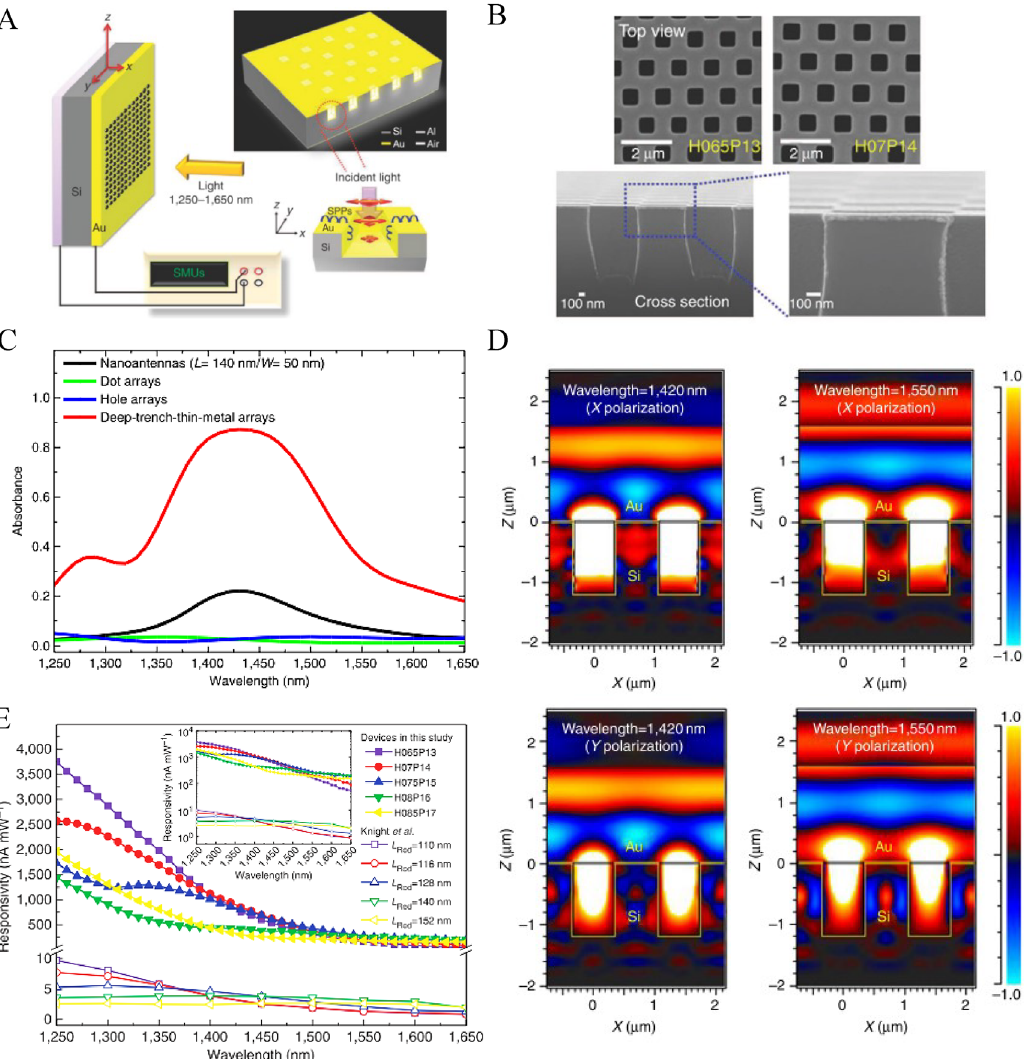
Figure 8: (A) Schematic representation and (B) top-view and cross-section SEM images of the active optical antenna-based device featuring DTTM antenna. (C) Simulated absorbance spectra of different plasmonic nanostructures, including DTTM antenna, nanorods, dot arrays, and hole arrays. (D) The electric field distributions of the light at the wavelengths of 1420 and 1550 nm propagating through the DTTM antenna structure on a Si substrate. (E) Measured spectral responsivities of the DTTM antenna-based devices featuring different dimensions of hole and period and those of the active optical antenna-based devices featuring different lengths of nanorods [44]. Copyright 2014, Springer